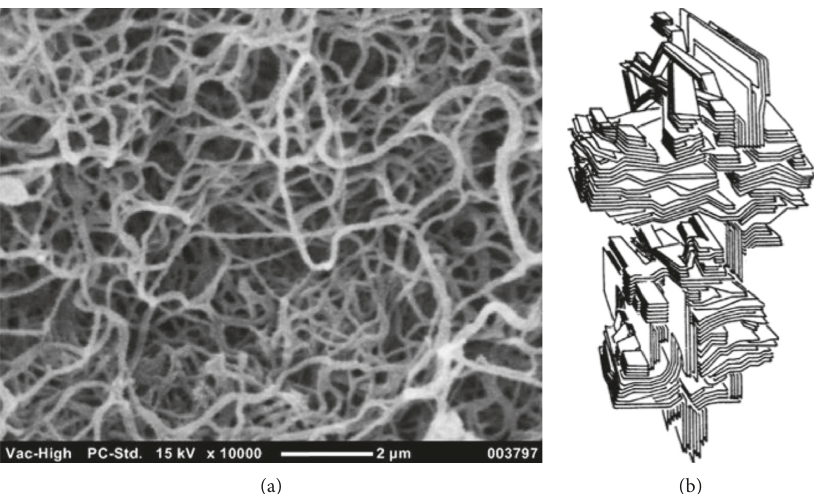
Figure 6: (a) SEM image of a mat of carbon nanofibers with an average diameter of ∼ 200nm (image taken from our research group) and (b) model of the microscopic 3D carbon structure inside the bulk of a carbon fiber with graphitic and turbostratic layers (image taken from